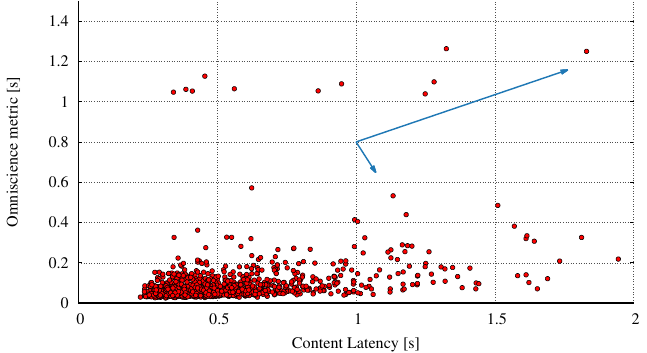
Figure 3. Scatter plot of the client 3 using the gateway